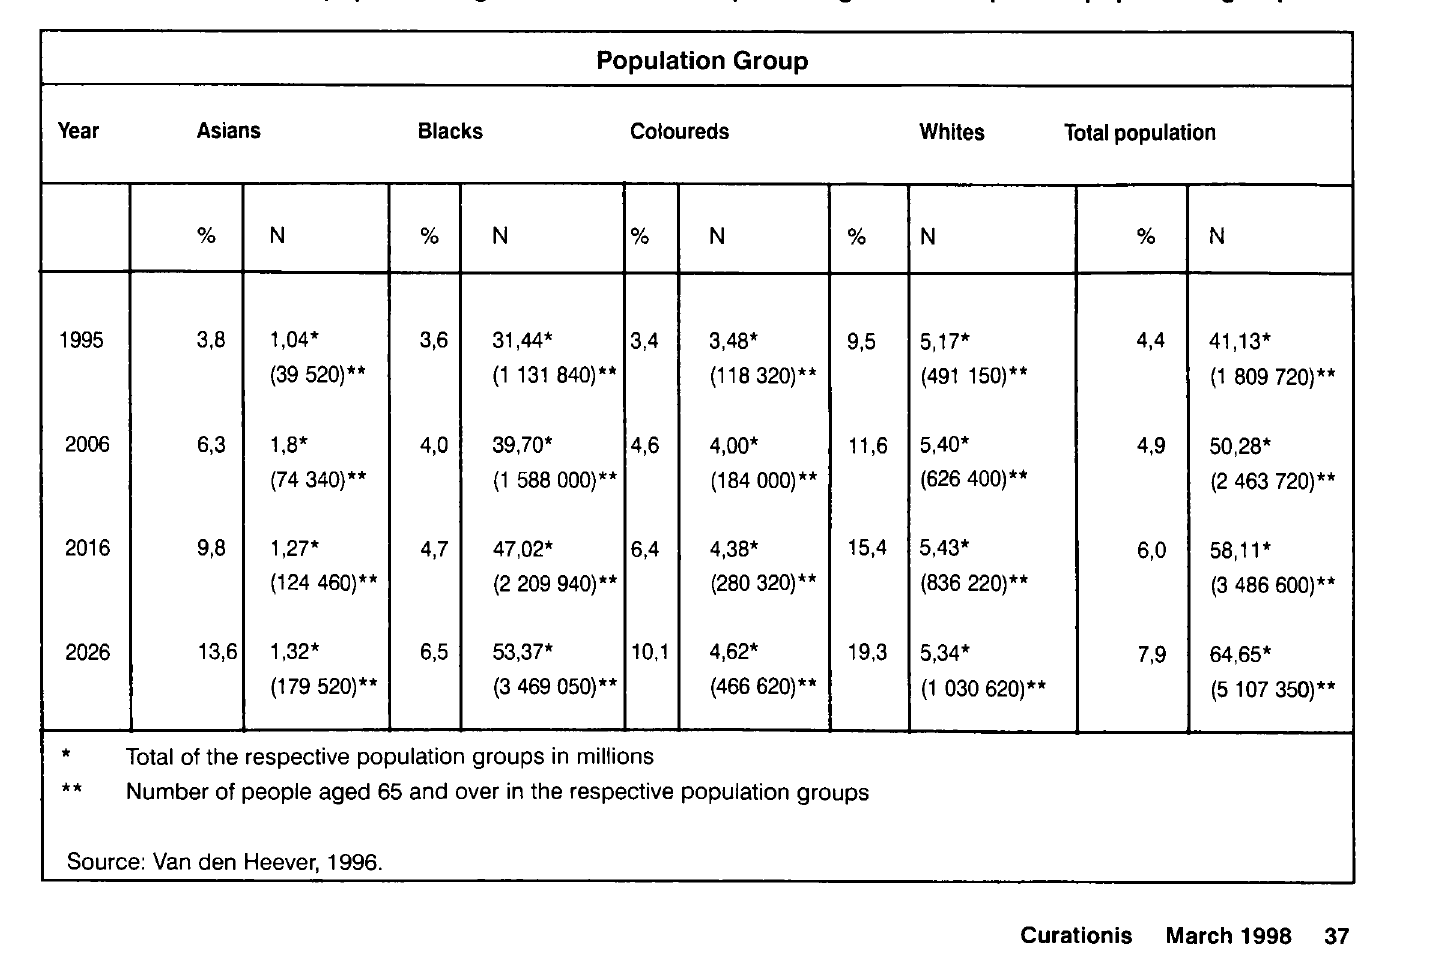
The South African population aged 65 and over as a percentage of the respective population groups Population